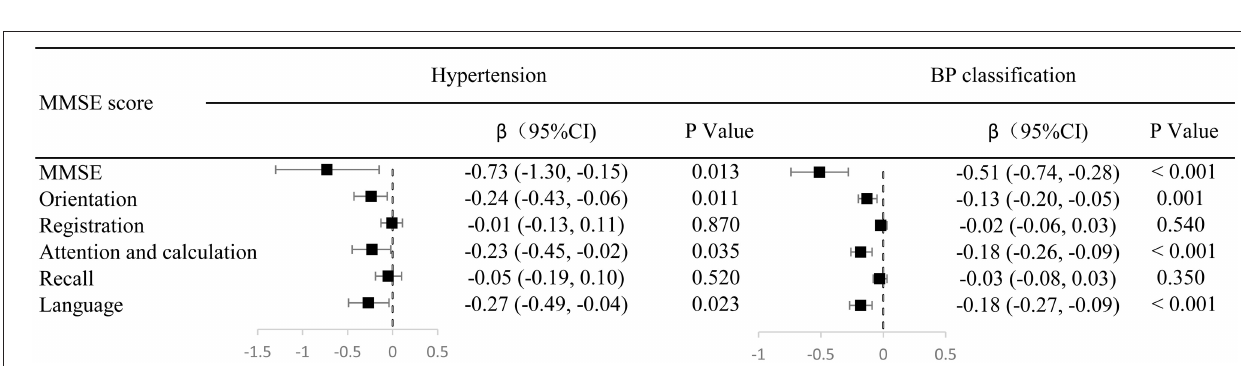
FIGURE 2 | The relationship between hypertension/hypertension classification and cognitive impairment in the multivariate analysis. Figure shows a significant difference between hypertension and cognitive impairment (odds ratio, 1.42; 95% confidence interval: 1.01–1.99; P = 0.047). Compared with normal blood pressure, there were no significant differences between stage 1 hypertension ( P = 0.84) and stage 2 hypertension ( P = 0.05) and the prevalence of cognitive impairment; in contrast, there was a significant positive correlation between stage 3 hypertension (odds ratio, 1.73; 95% confidence interval: 1.13–2.66; P = 0.012) and the prevalence of cognitive impairment.